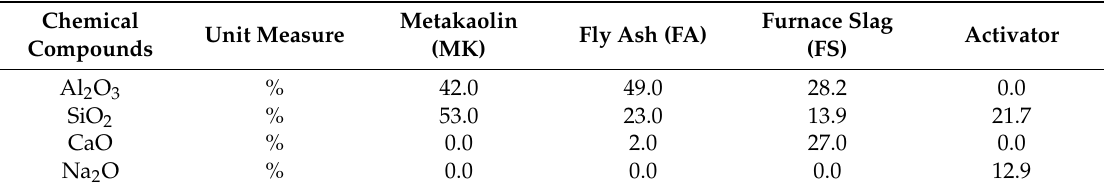
Table 1. Composition of precursors and activator used for alkali-activated binder development (all the percentages are intended by